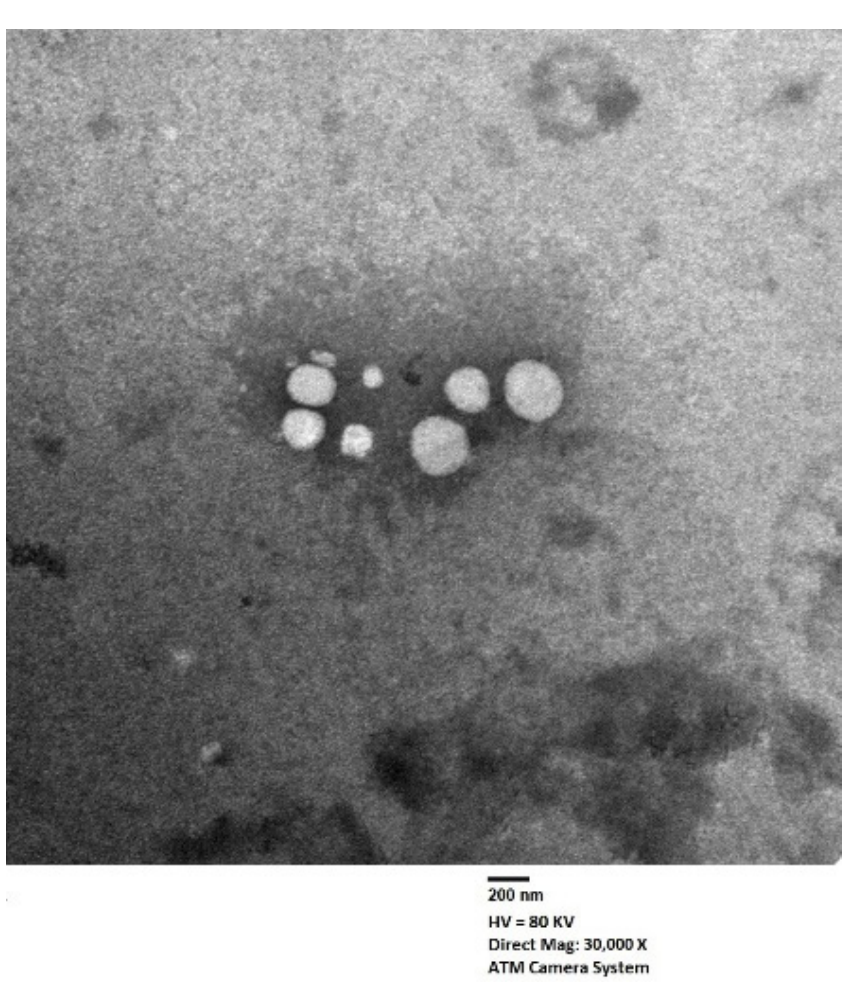
Figure 7. Transmission electron micrograph of optimized EGA-EML-APA. Abbreviations: EGA, ellagic acid; EML, emulsomes; APA, apamin.